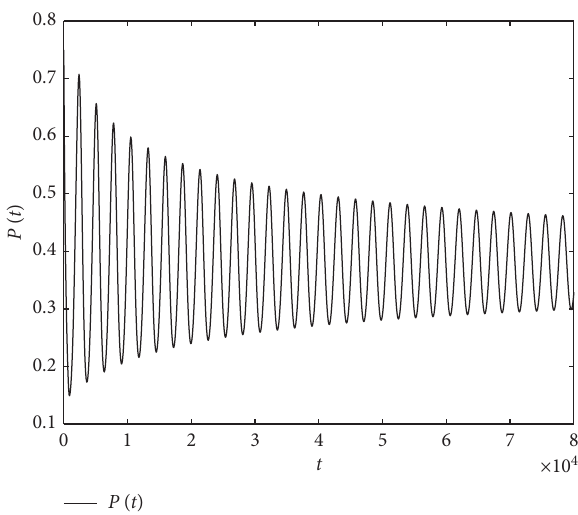
Figure 12: Time series solution of system (30) with ϕ � 0 . 90, � 728 . 403. τ � 740 > τ 0